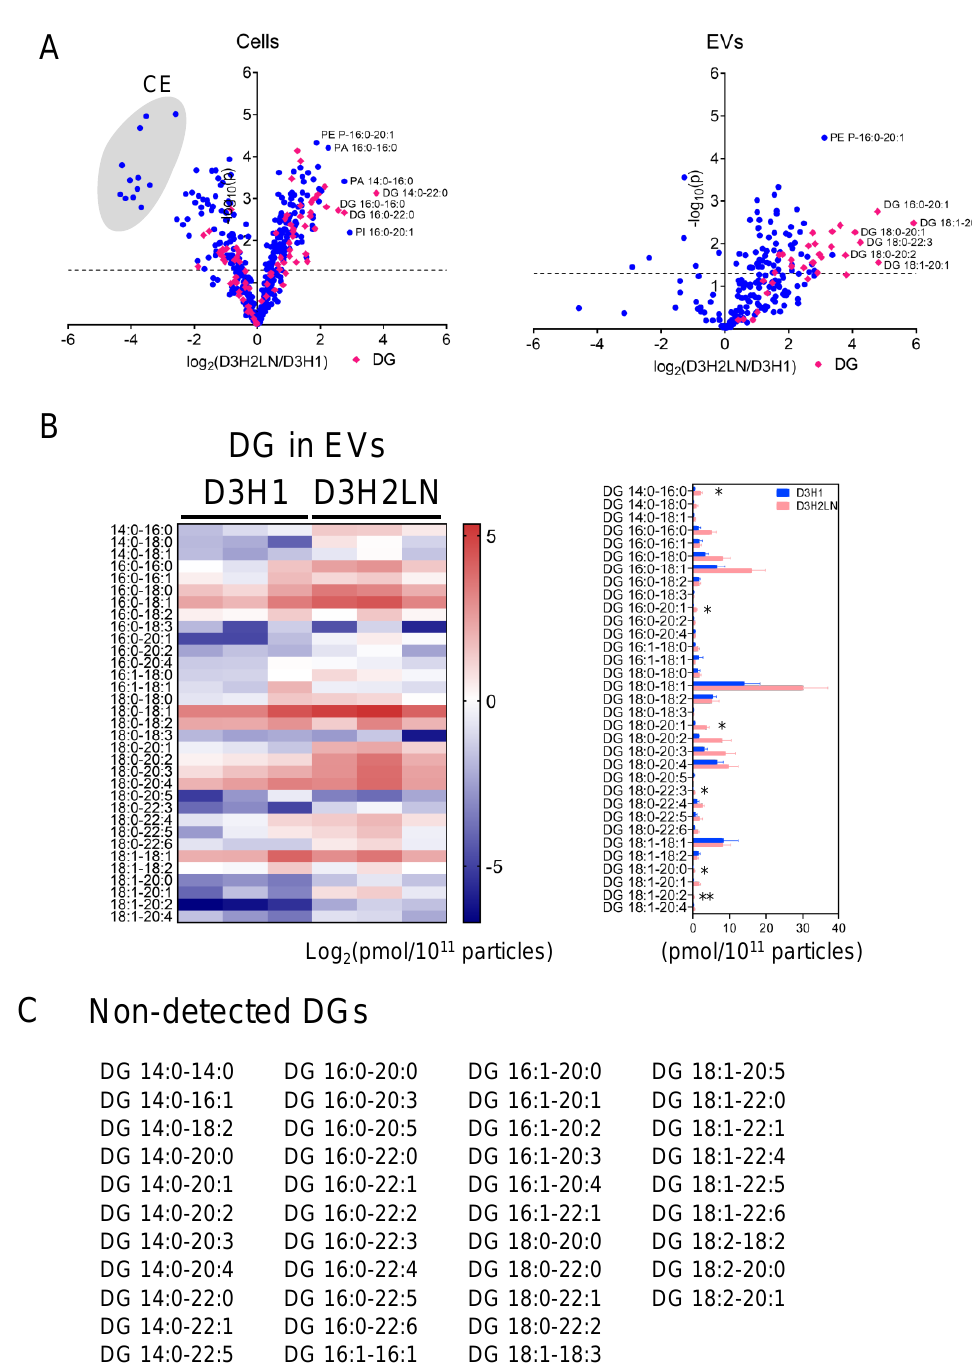
Figure 3. Comparison of individual lipid species between D3H1 and D3H2LN in cells and EVs. ( A ) Volcano plots of fold changes of individual lipid molecules between D3H1 and D3H2LN based on mol percentile to the total detected lipids. Left: cells, Right: EVs. p -value was analyzed by an unpaired two-tail Student’s t-test. The plots marked in pink diamonds are DGs. ( B ) (Left) A heatmap of log-based mol quantities of DG species in EVs of D3H1 and D3H2LN, normalized by particle number of EVs. Each column indicates the measurement from three independent samples. (Right) Mol quantity of DGs normalized to particle number of EVs from D3H1 and D3H2LN. The bar graphs indicate mean ± SEM. (C) A list of DG species not detected in both D3H1 and D3H2LN EVs. *** p < 0.001, ** p < 0.01, * p < 0.05, Student’s t-test (unpaired,